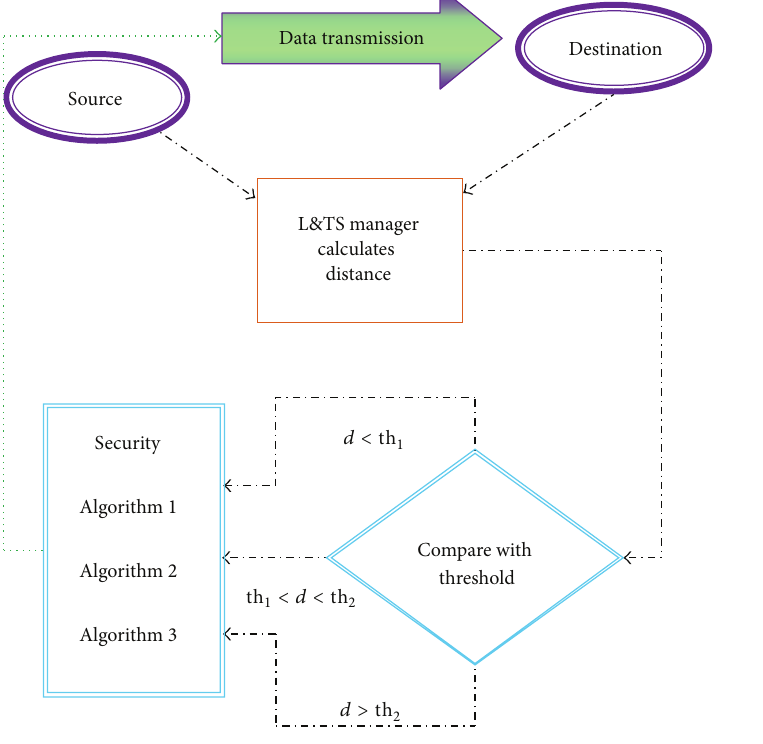
Figure 2: Working of the L&TS scheme.